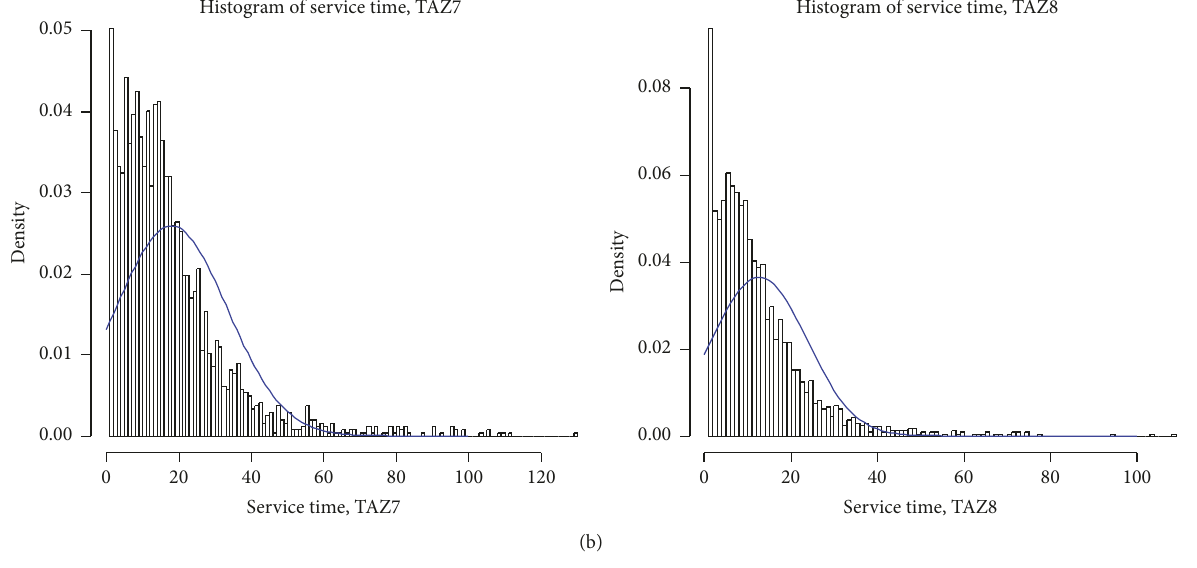
Figure 5: The taxi vehicles’ pick-up service frequency statistics of each TAZ in Shenzhen. Table 5: Calculation table of taxi station’s service radius (unit: